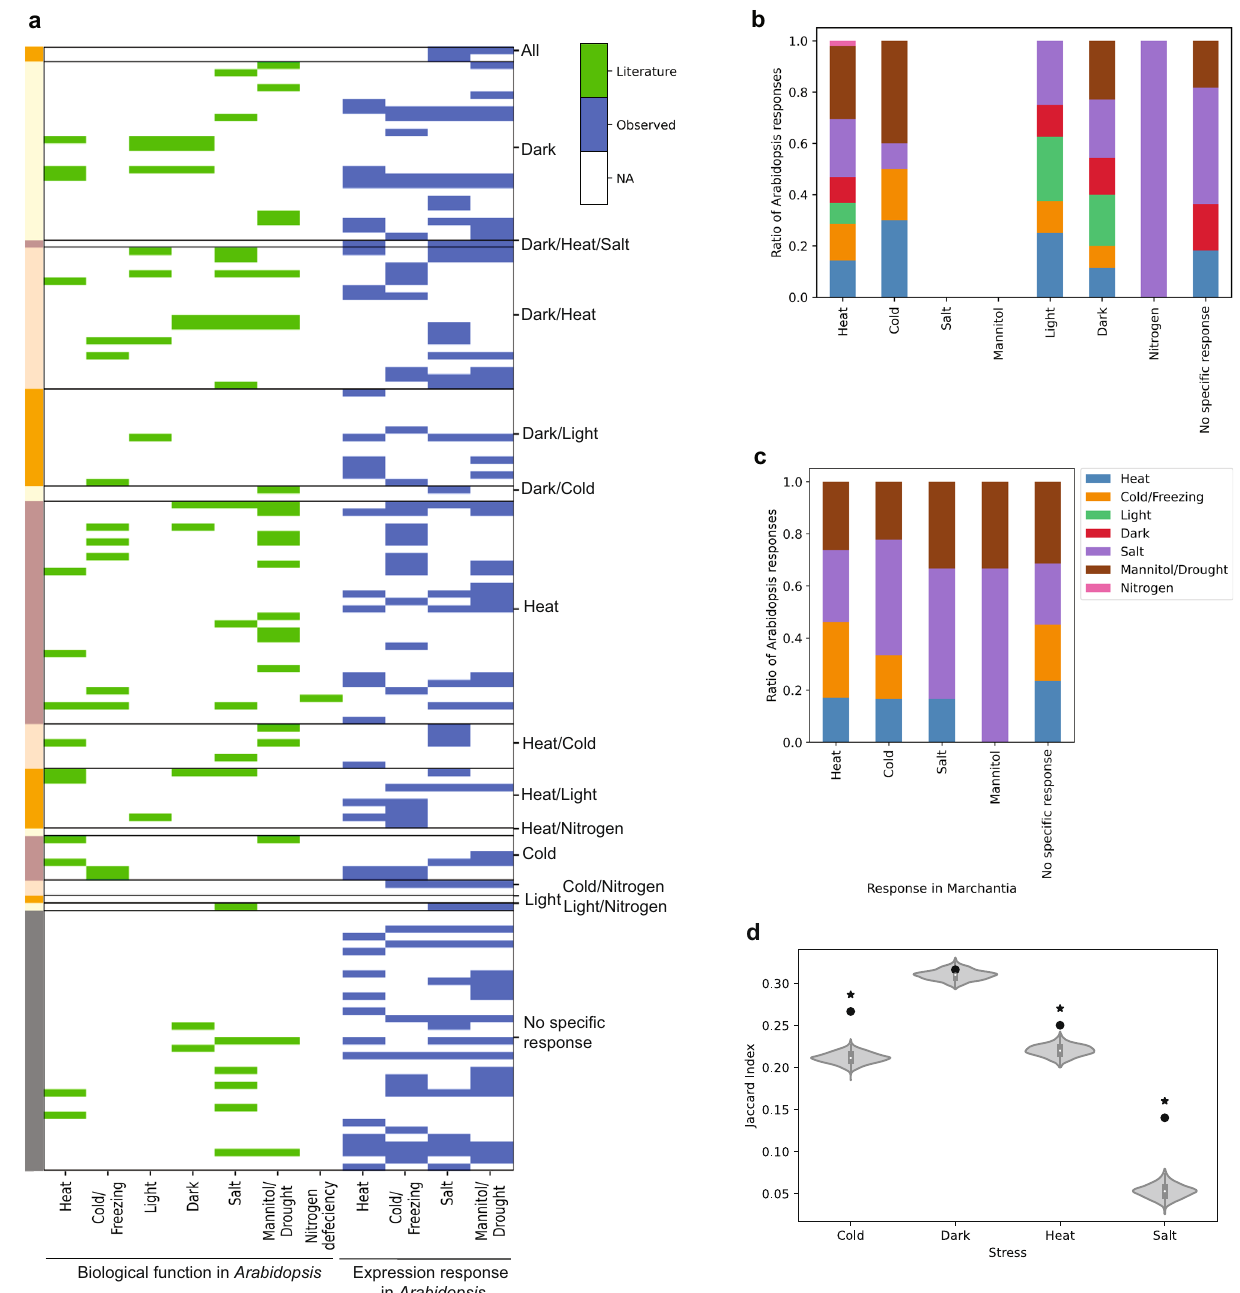
Fig. 5 | Comparisonofstress-responsivetranscription factors in Marchantia to Arabidopsis orthologs. a The functionof Arabidopsis thaliana orthologs, inferred from the literature (green, obtained from NCBI, Arabidopsis.org) and gene expression responses (blue, eFP browser). Each row contains one Arabidopsis TF, and the rows are grouped and color-coded according to the stress response in Marchantia . The columns indicate the stresses observed in Arabidopsis . b Ratio of evidence from the literature for Arabidopsis TFs grouped according to the stress speci fi city observed in Marchantia ( x -axis). c Ratio of evidence by observation of change in expression in Arabidopsis TFs based on expression data (source eFP browser). High light, dark, and nitrogen de fi ciency are omitted due to the lack of data. ‘ No speci fi c response ’ comprises transcription factors that were not robustly